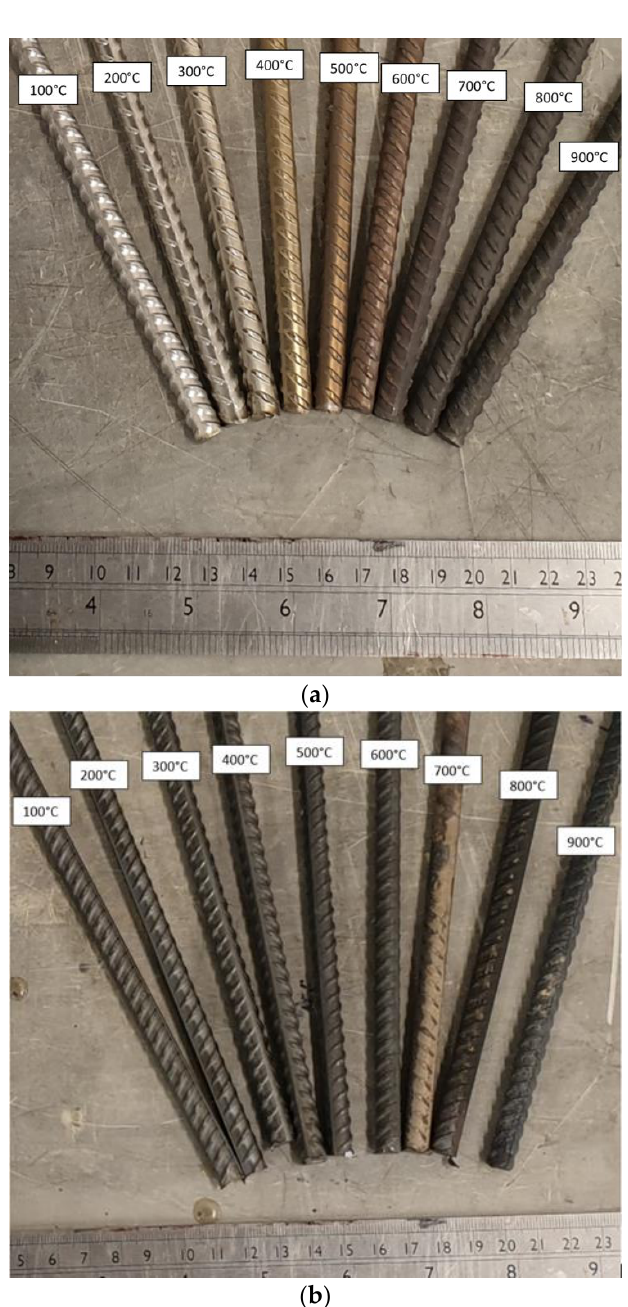
Figure 2. ( a ) Grade 1.4301 stainless steel and ( b ) grade B500B carbon steel samples following